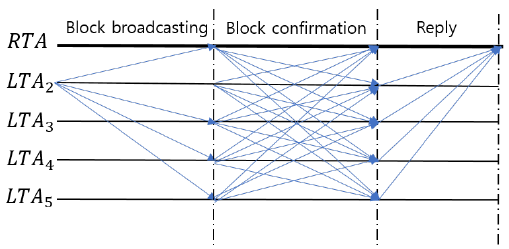
Figure 11. Block confirmation